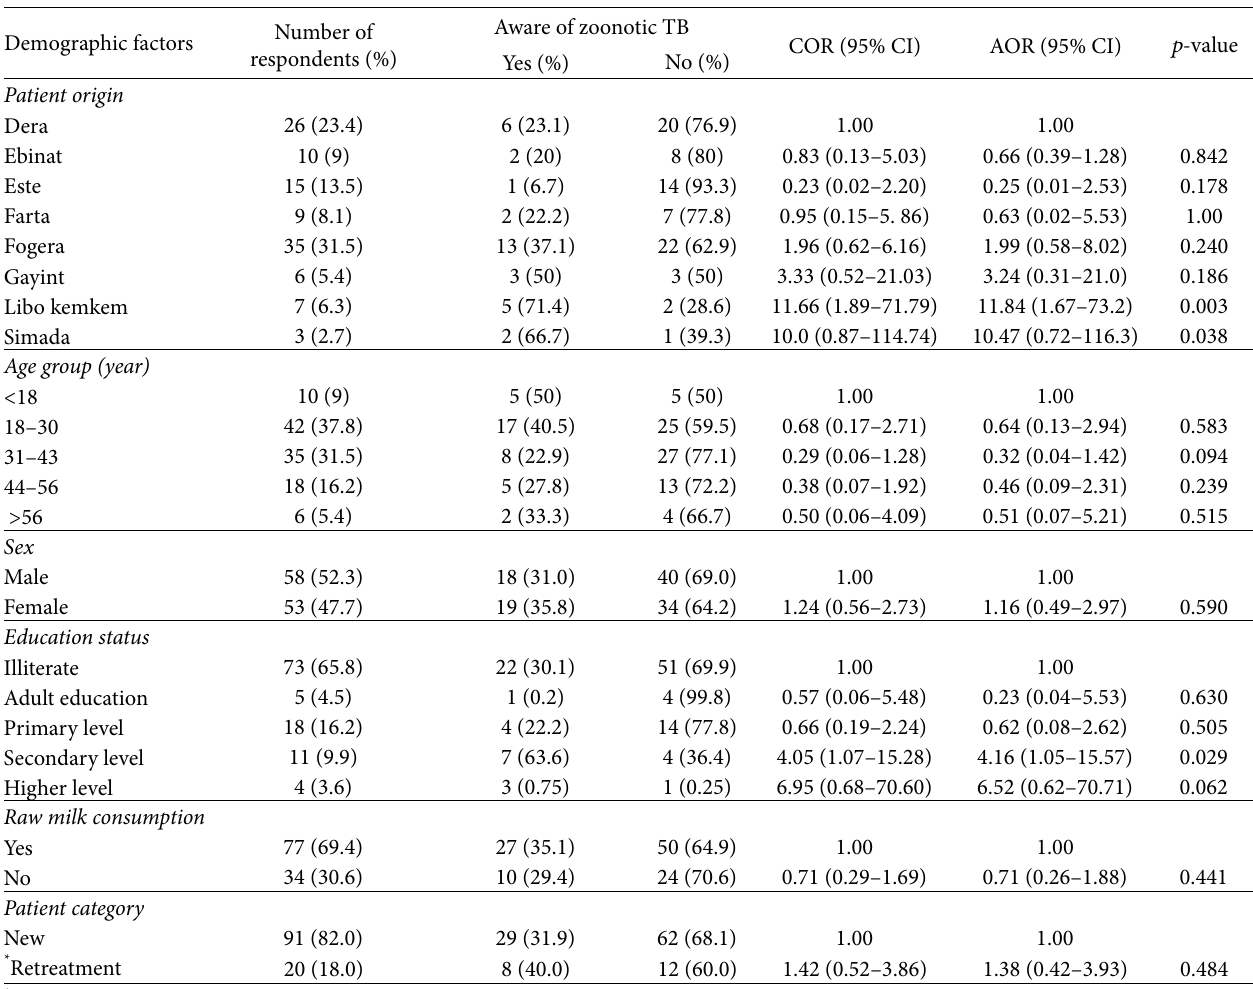
Table 1: Association of demographic factors with awarness to zoonotic transmission of TB among AFB culture positive TB patients (𝑁 = 111) , South Gondar Zone, northwest Ethiopia